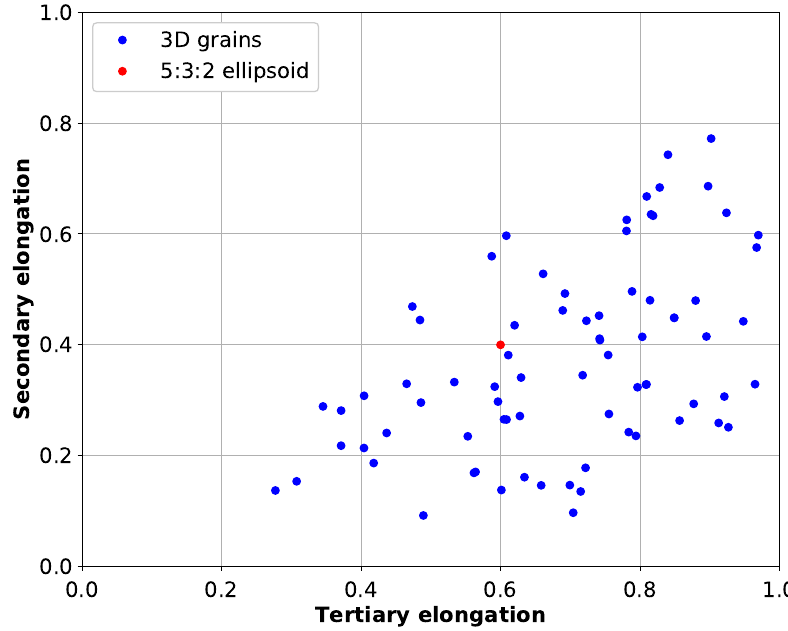
Figure 8. Comparisons of secondary and tertiary equiaxed dendritic grain elongation factors.